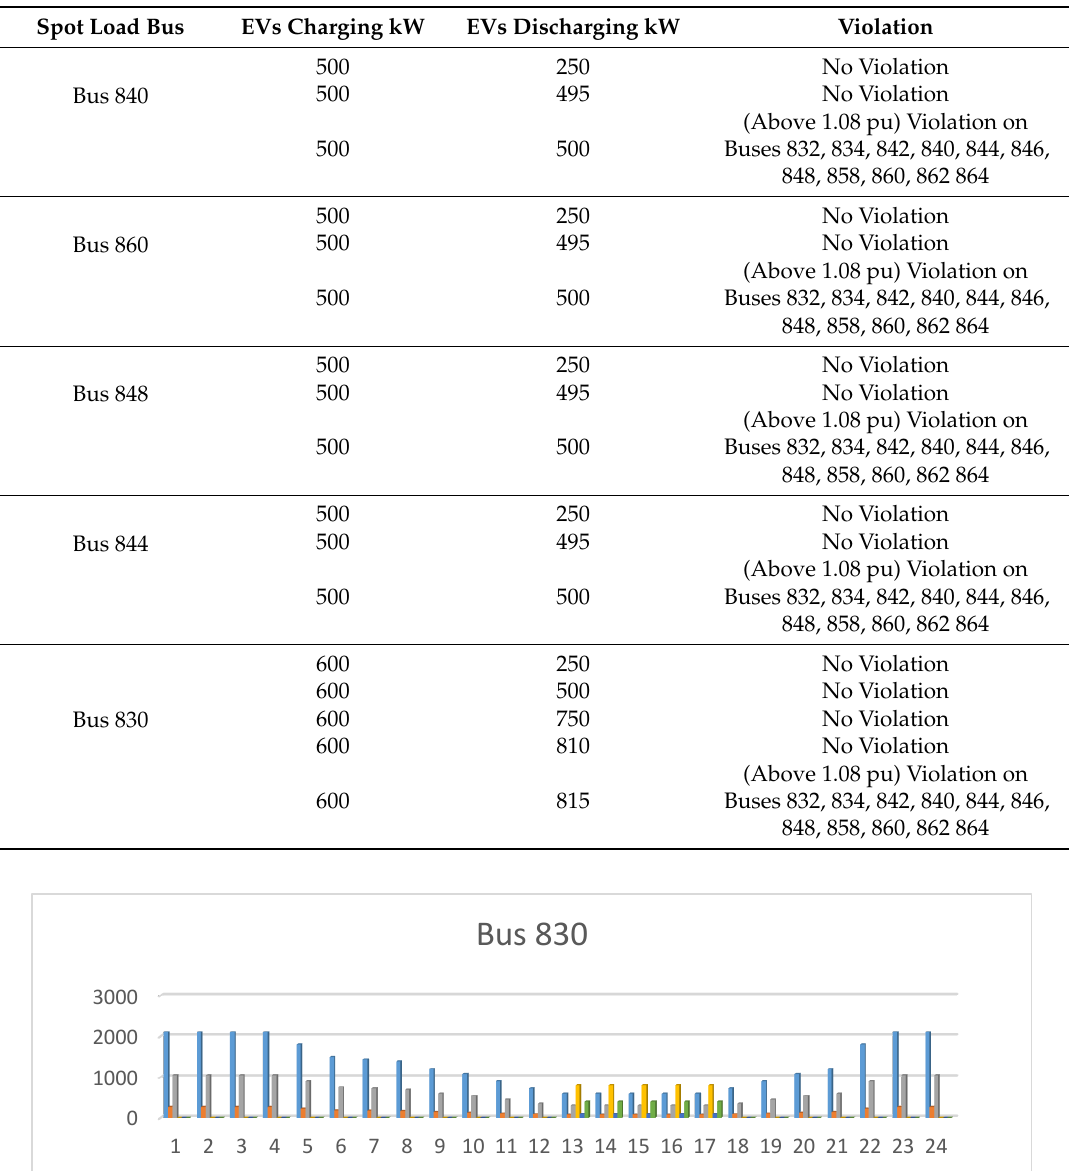
Table 7. Case 3 Maximum Charging/Discharging Load kW during Peak Hours.